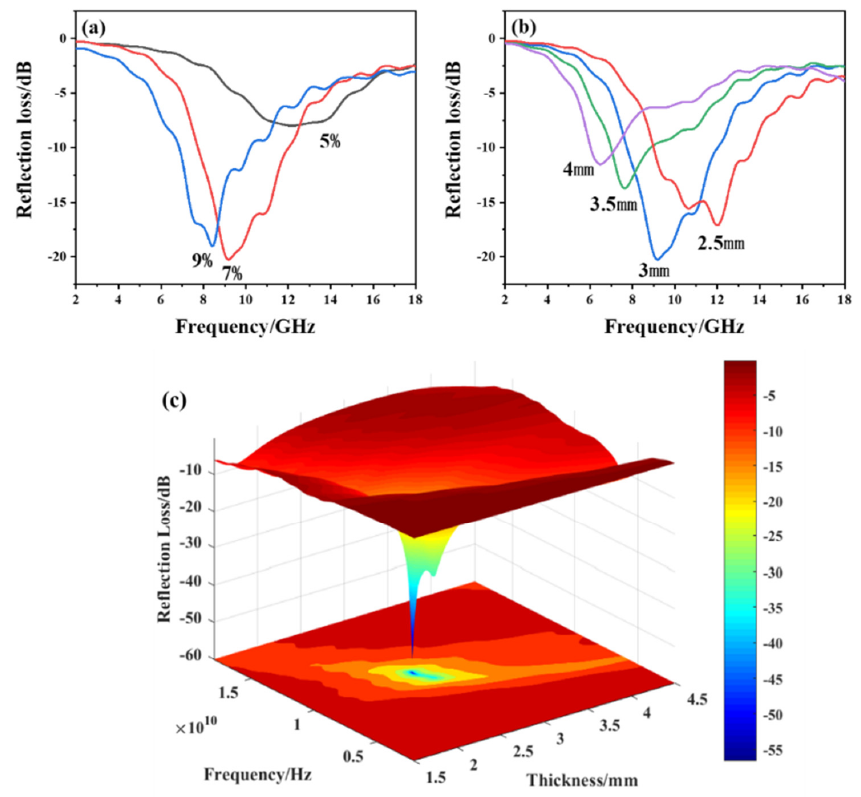
Figure 6. Reflection loss of HPCNF composites: ( a ) different contents of HPCNF at 3 mm thickness; ( b ) varied thicknesses at HPCNF content of 7%; ( c ) relationship between reflection loss and thickness as well as frequency at HPCNF content of 7%.